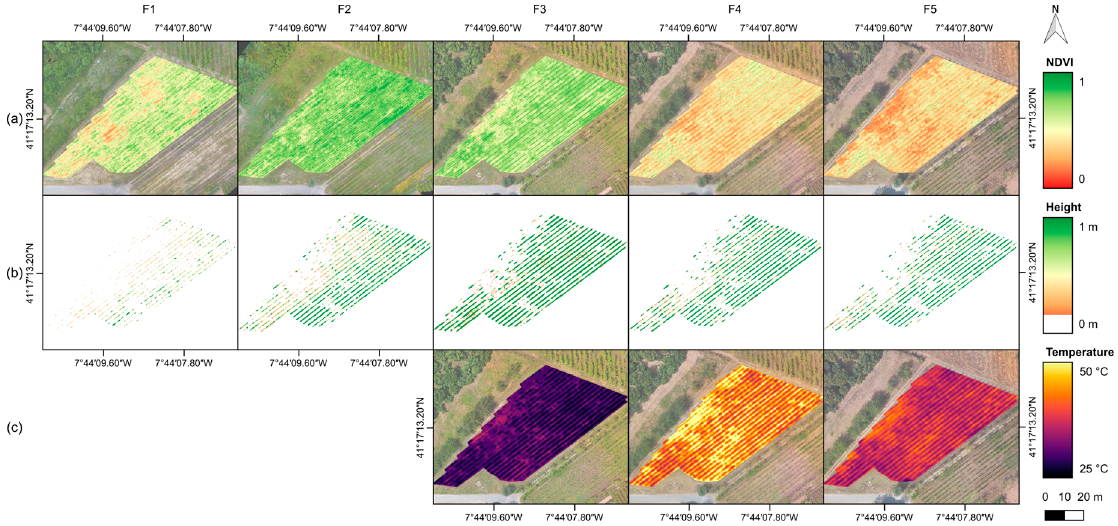
Figure 5. Orthorectified outcomes generated with data acquired in each flight campaign using a colour-code representation: ( a ) normalized difference vegetation index, ( b ) crop surface model, and ( c ) land surface temperature. Orthophoto mosaics are presented as the background of (a) and (c).